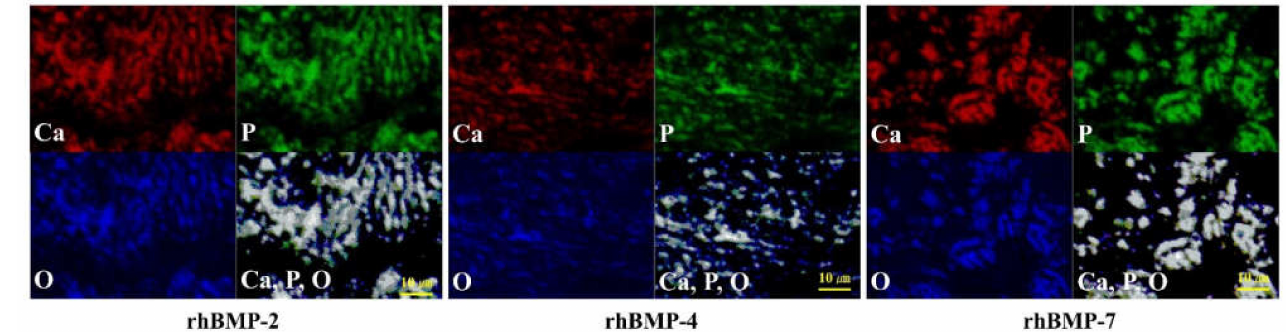
Figure 2. EPMA analysis of the elemental compositions of rhBMP-2, rhBMP-4, and rhBMP-7 samples two weeks after cultivation. Calcium (Ca; red), phosphorus (P; green), and oxygen (O; blue) were detected in the extracellular matrix. All three elements were confirmed to be at almost identical positions (white). Scale bar size is 10 µ m.